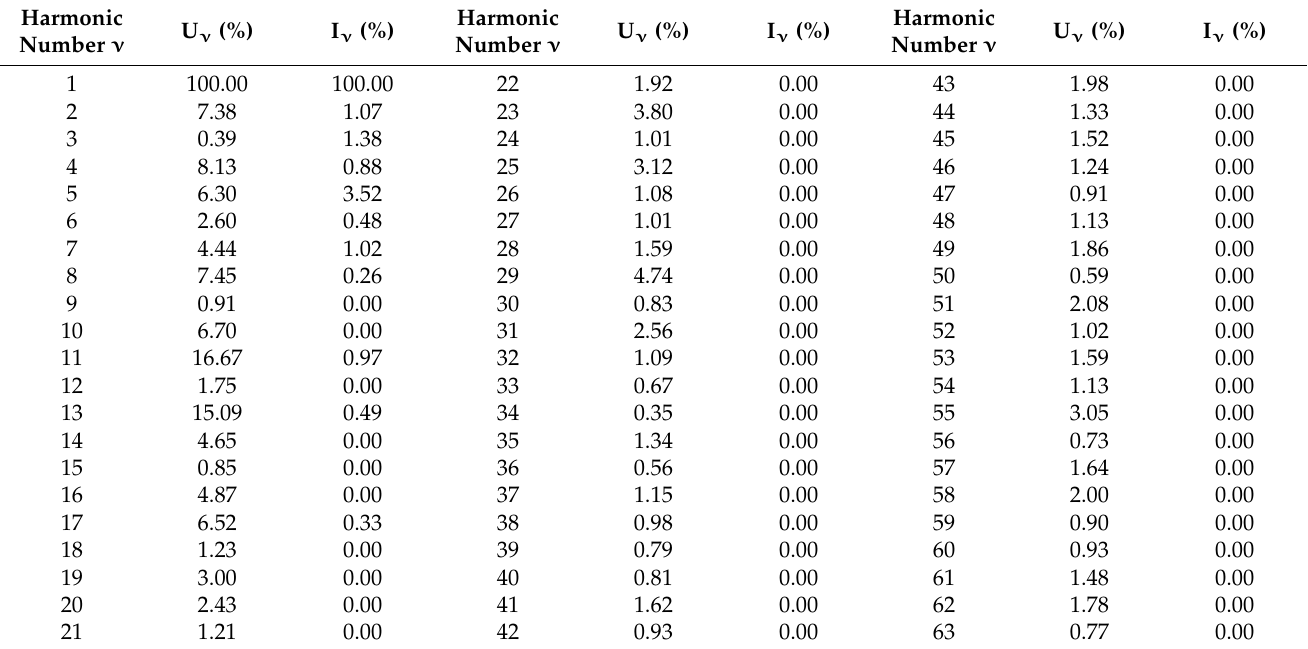
Table 4. The values of the currents and voltages harmonic.